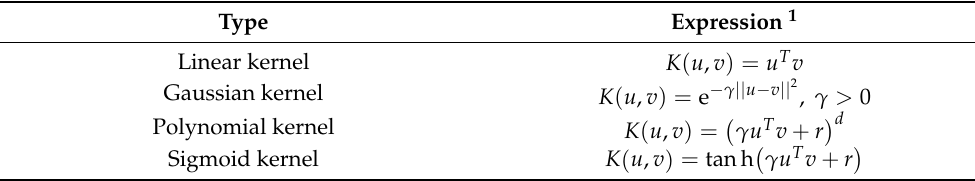
Table 4. Specification of kernel